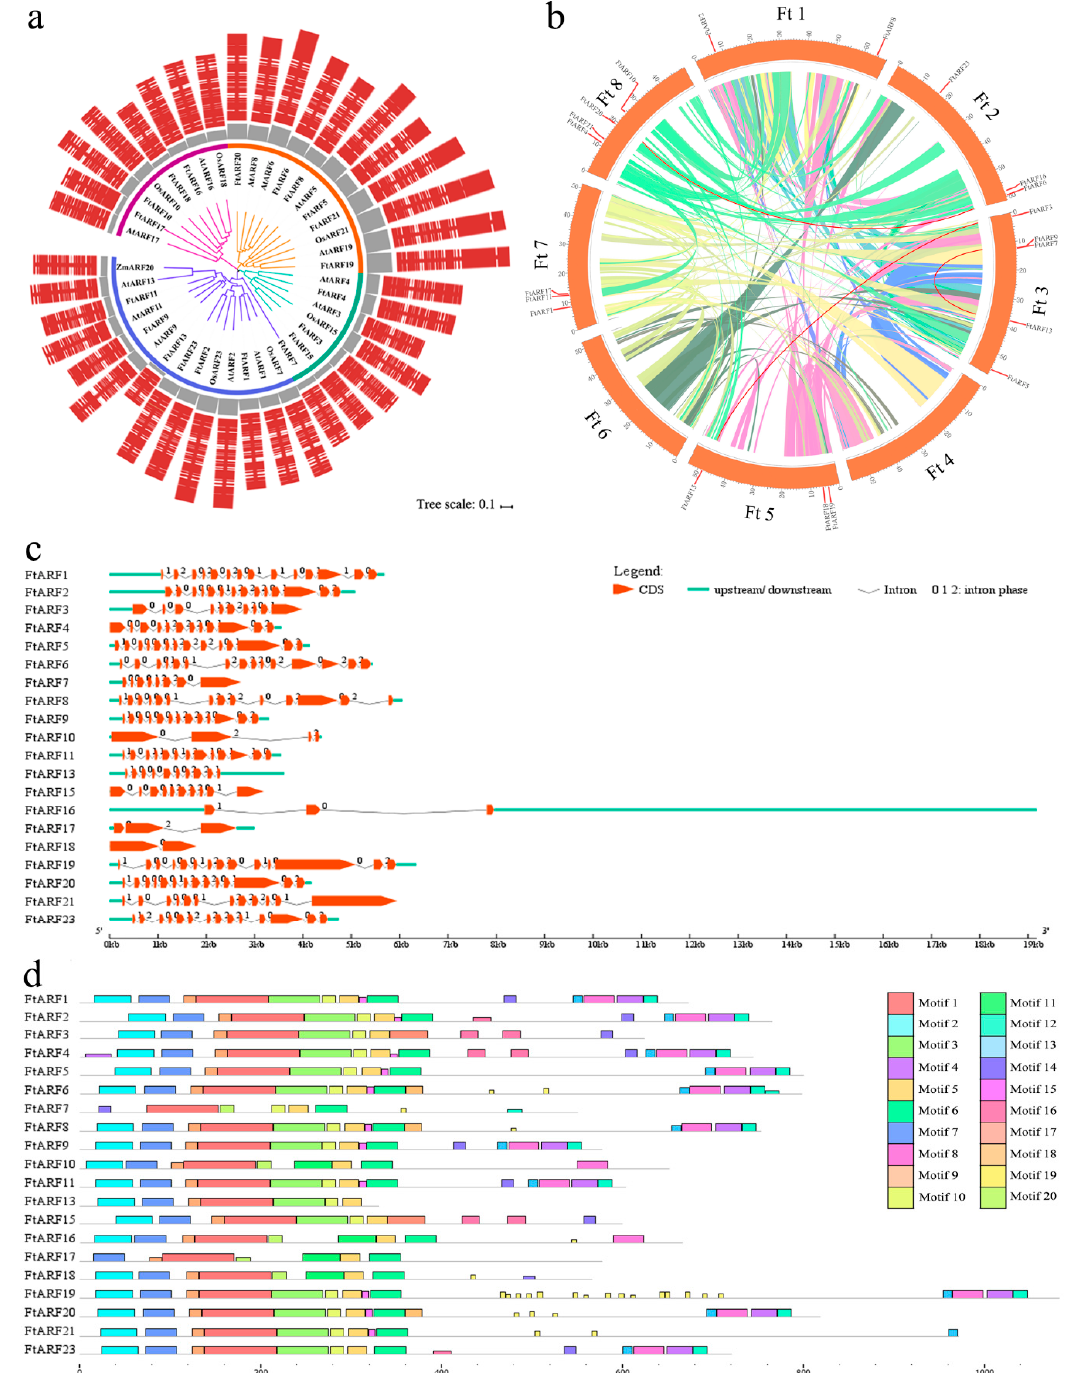
Figure 1. ARF gene family in tartary buckwheat. ( a ) Unrooted phylogenetic tree representing relationships among the FtARFs. The different-colored arcs indicate different groups. Gray columns represent protein lengths. Red columns represent protein sequence structure. ( b ) Schematic representations of the chromosomal distribution and interchromosomal relationships of the FtARF genes. Colorized lines indicate all synteny blocks in the tartary buckwheat genome, and the red lines indicate duplicated ARF gene pairs. The chromosome number is indicated at the bottom of each chromosome. ( c ) Exon–intron structure of FtARF genes. Orange boxes indicate exons; green lines indicate introns. The number indicates the intron phase. ( d ) The motif composition of FtARF proteins. The motifs, numbered 1–20, are displayed in different-colored boxes. The sequence information for each motif is provided in Table S2. The length of protein can be estimated using the scale at the bottom.